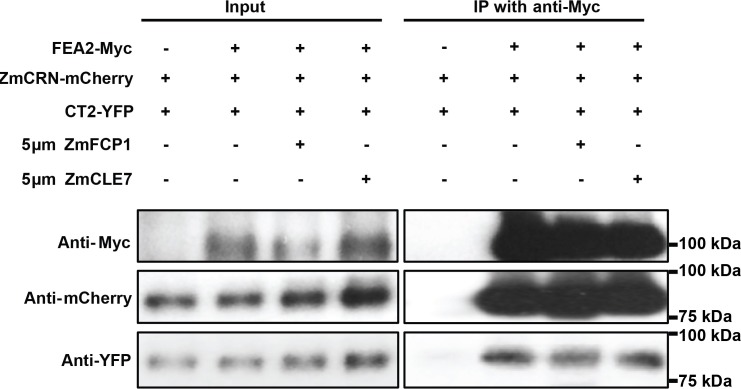
Treatment with ZmFCP1 or ZmCLE7 peptide didn’t affect the protein complex formation.5 μm ZmFCP1 or ZmCLE7 were infiltrated into the transformed N. benthamiana leaves expressing the indicated proteins following the protocol in Somssich et al. (2015). The presence of ZmFCP1 or ZmCLE7 didn’t affect the interaction between FEA2-Myc and CT2-YFP or the interaction between FEA2-Myc and ZmCRN-mCherry.